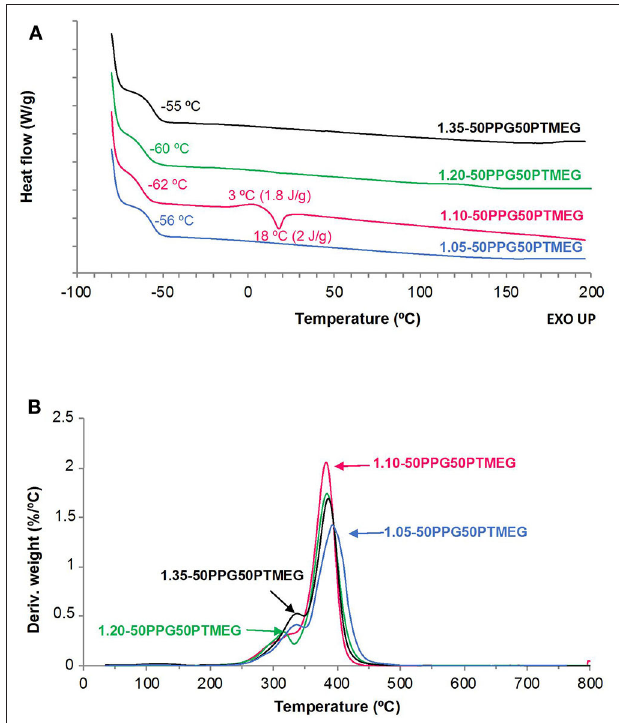
FIGURE 4 | (A) DSC traces (second heating run) and (B) variation of the derivative of the weight as a function of the temperature for TPUs synthesized with 50 wt% PPG + 50 wt% PTMEG and different NCO/OH ratios.